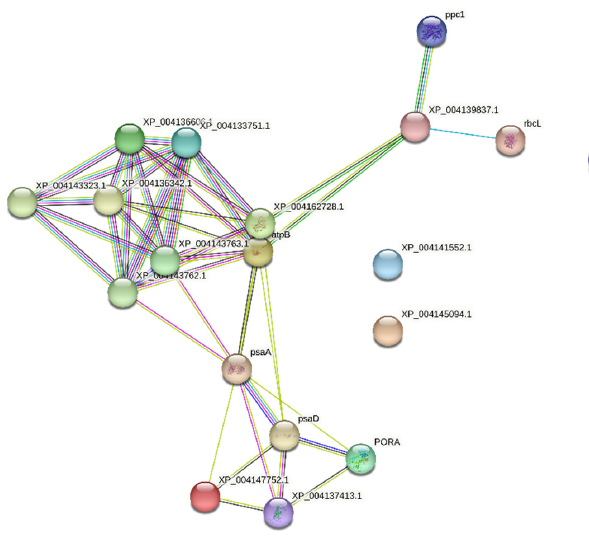
Figure 11. The functions of the main differential proteins in different crossing periods. Among the metabolic interconversion enzymes (PC00262), Gene Ontology classifi- cation further classified 1835 proteins (Figure 10). Protein-modifying enzymes (PC00260) are the first category of metabolic interconversion enzymes, followed by transporters (PC00227) and translational proteins (PC00263). The oxidoreductase consists of alcohol dehydrogenase, catalase, choline oxidase, and enzymes involved in glycolysis, the TCA cycle, oxidative phosphorylation, and amino acid metabolism. The transferases include glutathione reductase, glutathione, glutathione S-transferases, and coenzyme A (CoA). Other categories of enzymes included were calcium-binding proteins (PC00060), chap- erones (PC00072), membrane traffic proteins (PC00150), chromatin binding/regulatory proteins (PC00077), and RNA metabolism proteins (PC00031). The overall result of protein identification and the results of differential proteins are shown in Figure 11.